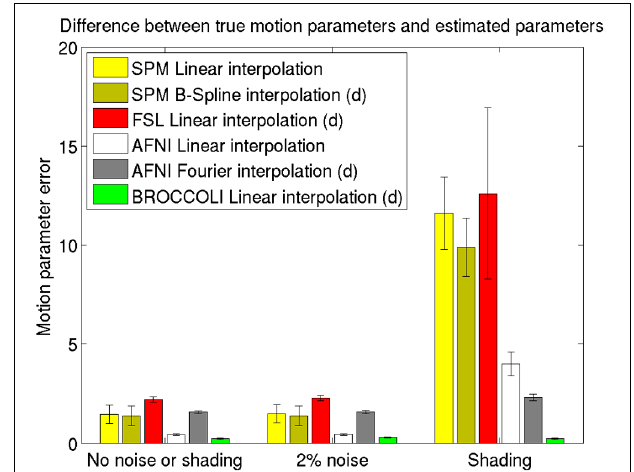
FIGURE 7 | Motion parameter errors for the different software packages, averaged over 198 datasets with artificial motion. The error bars represent the standard deviation. The testing datasets were generated by applying random translations and rotations to the first fMRI volume in each dataset, and then adding Gaussian noise or a shading. The amount of noise was defined by setting the standard deviation to a percentage of the maximum intensity value. Different interpolation modes were tested, as the software packages have different default settings for interpolation (d denotes the default interpolation). The presented results were generated with an Nvidia GPU, and equal results were also obtained by the Intel CPU and the AMD